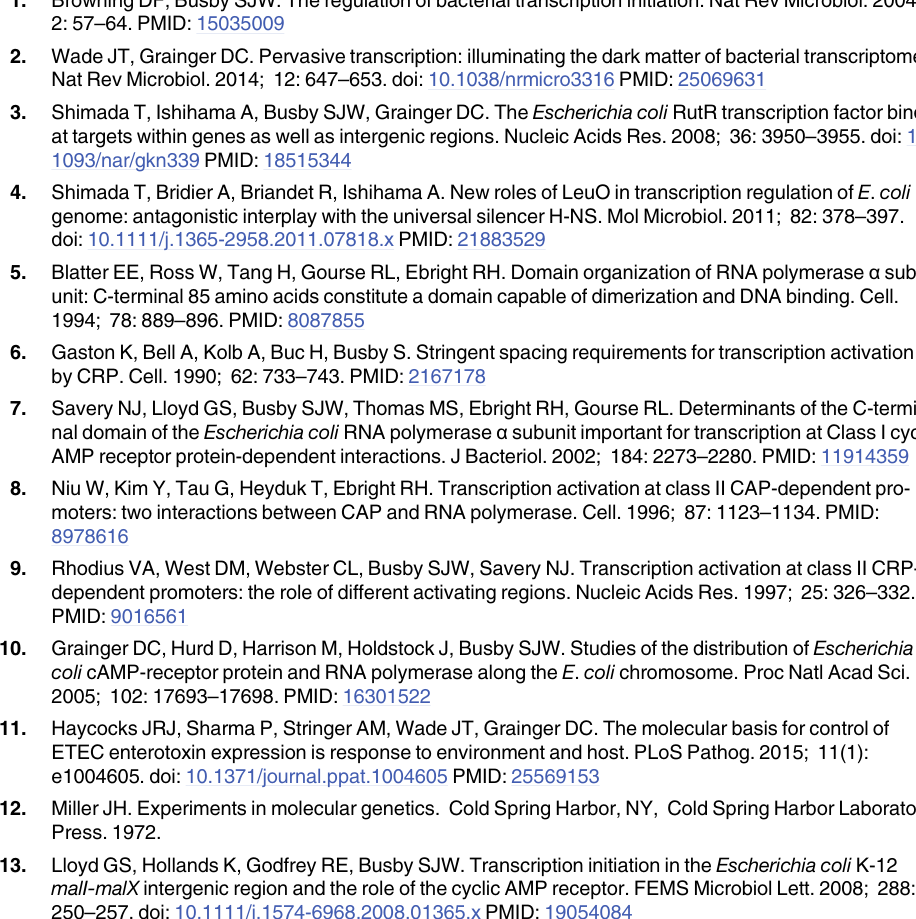
S1 Fig. Raw gel images. Panels A-C show raw gel images from Figs 2A, 2C and 3 respectively.